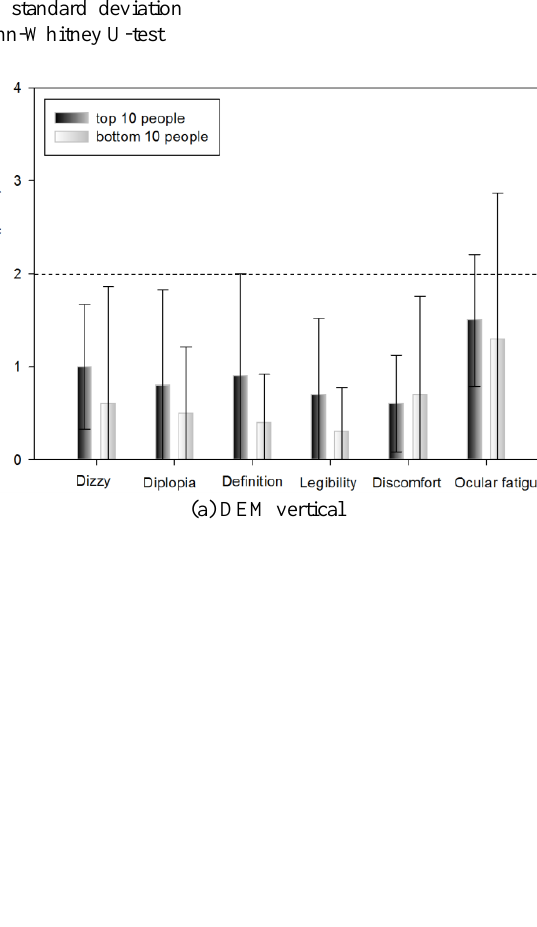
DEM horizontality Top 10 people (16.14±0.81) Bottom 10 people (25.05±3.37)